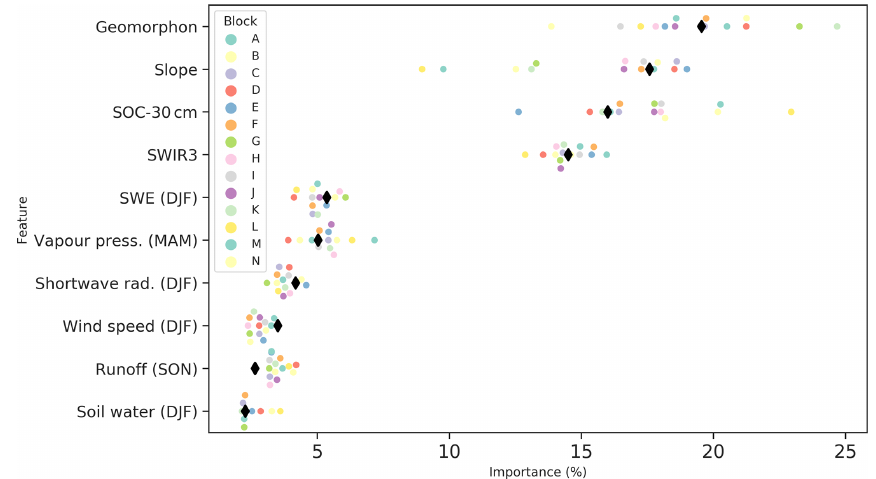
Figure 3. Predictor importance based on percent information gain for the top 10 features as determined by the LightGBM algorithm. The feature ranking is shown for each of the blocks used during the BLOO CV (coloured dots; see Sect. 2.4.2). The feature importance from the full model simulation is shown by the black diamonds. SWIR3 is the shortwave infrared radiation reflectance for 2225–2275nm, geomorphon is the geomorphological landform, SWE is the snow water equivalent, and SOC is soil organic carbon at 30cm depth. See Table 1 and Sect. 2.2.1 for more